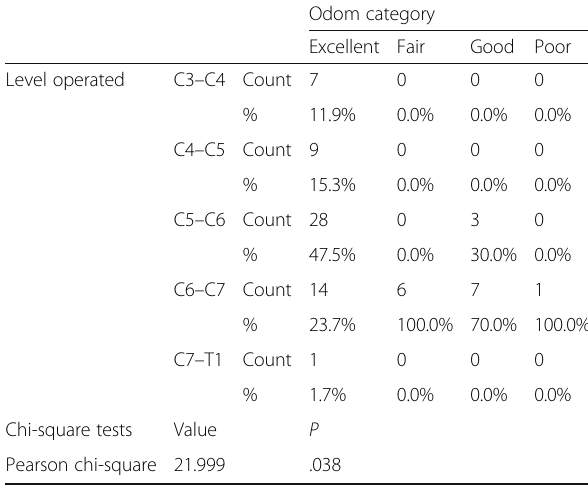
Table 2 Odom ’ s category in relation to disc level